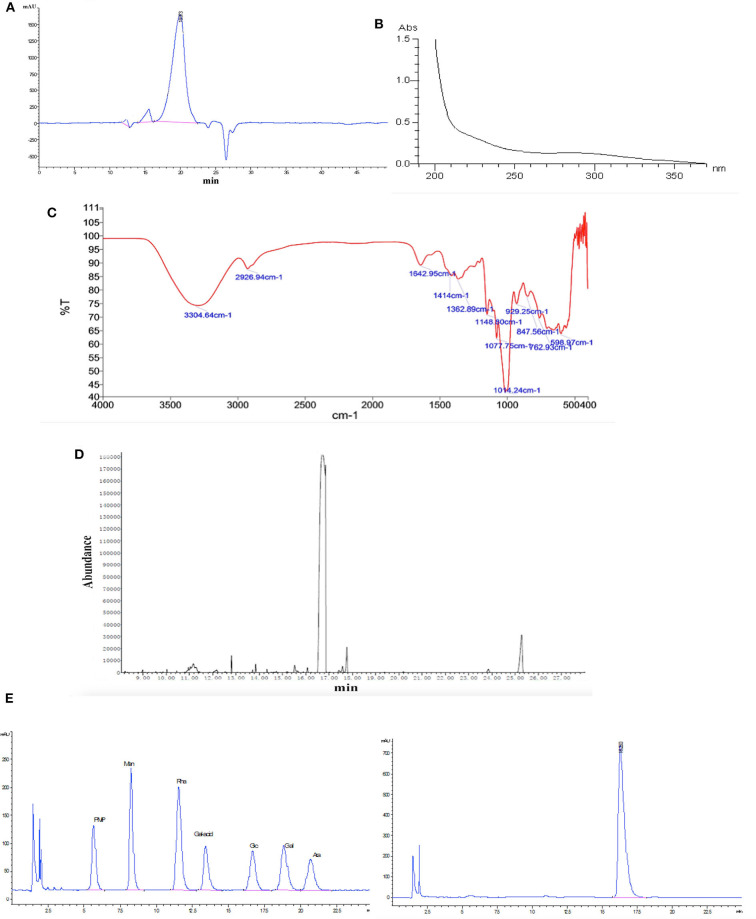
Characterization of HPP by (A) high-performance gel permeation chromatography (HPGPC), (B) UV scanning spectrum, (C) infrared spectrum, (D) gas chromatography of the glucose standard (16.6 min), and (E) gas chromatography of the HPP sample (16.5 min).